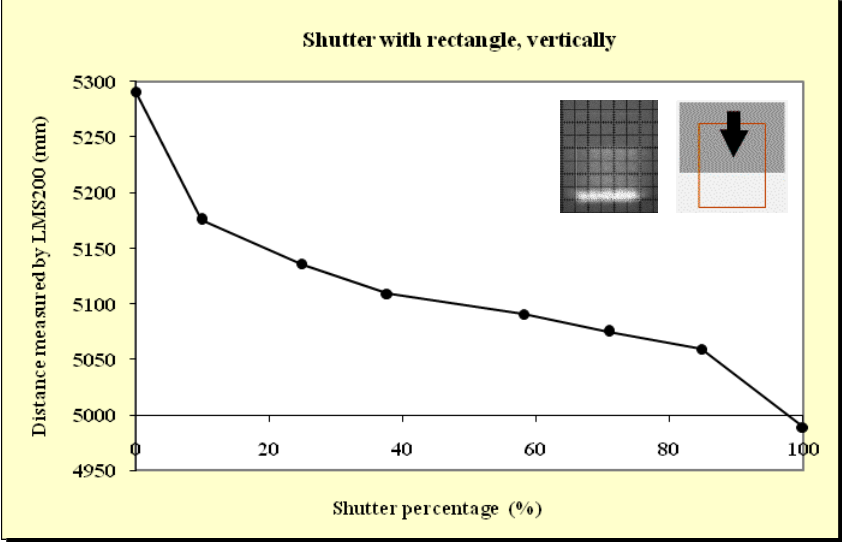
Figure 15. Graphic representation of the evolution of the distance measurement given by the sensor when the laser beam (90°) was incrementally blocked (from top to bottom) using the rectangular shaped template at a distance of 5 m from the sensor and the unblocked part of the beam was captured by the grid template at a distance of 5.3